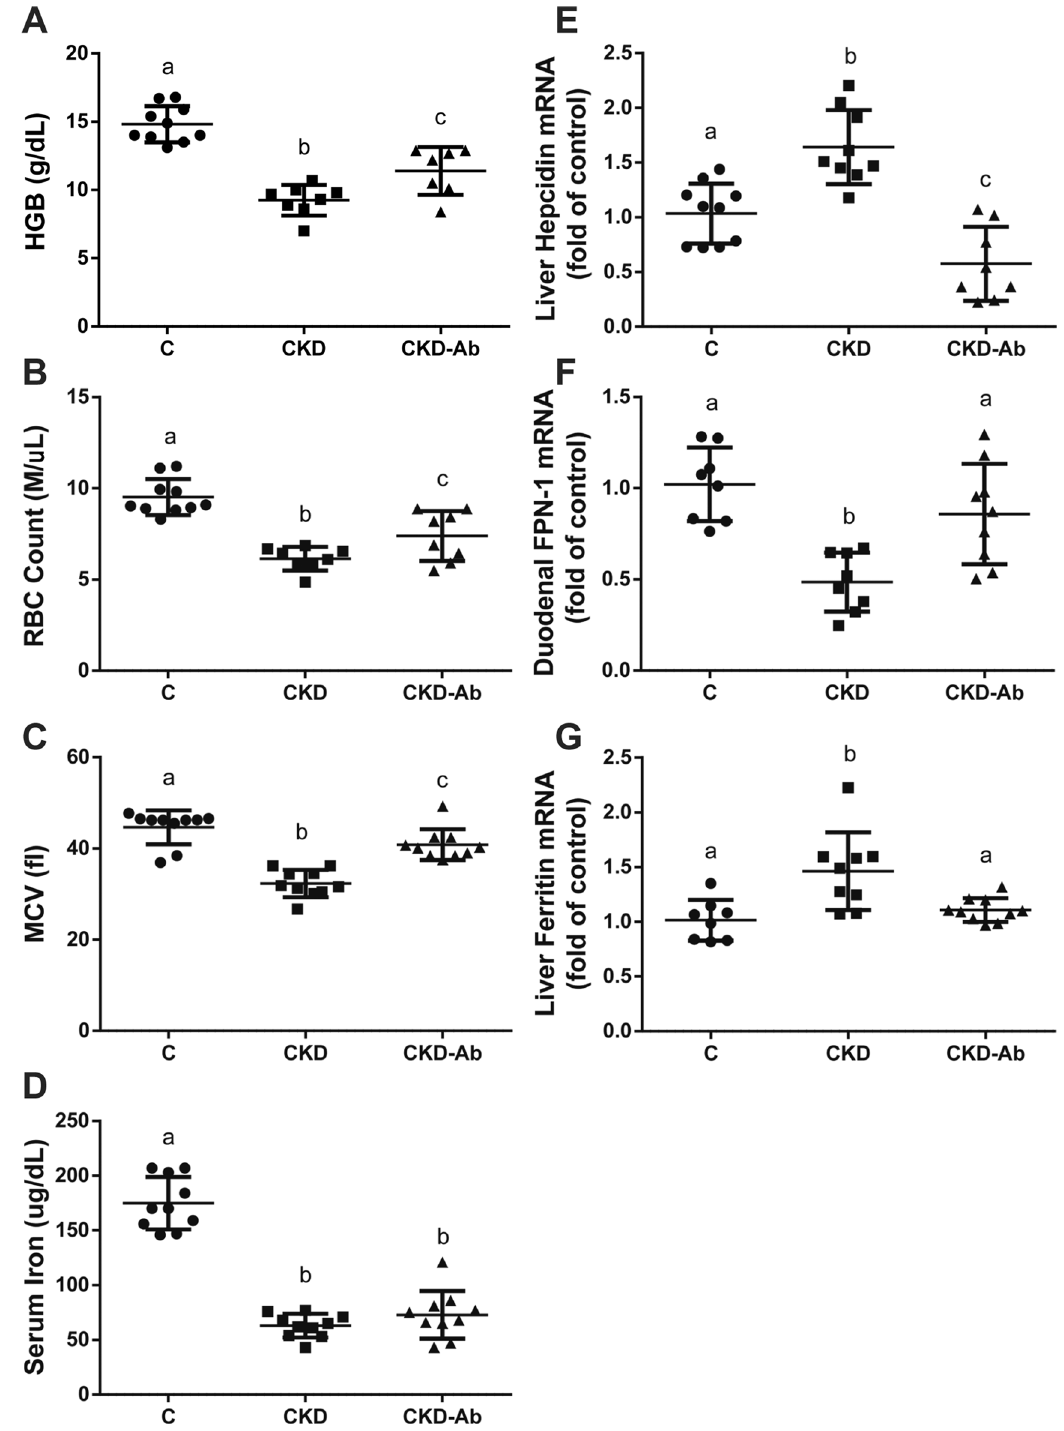
Figure 8. Anemia response of CKD mice to IL1 inhibition. Anemia and iron parameters in mice on regular (C) or adenine diet, injected with saline (CKD) or an anti-IL1 monoclonal antibody (CKD-Ab). Hemoglobin (g/dL) (A) . Red blood cell count (M/μL) (B) . Mean corpuscular volume (fl) (C) . Serum Iron levels (ug/dL) (D) . Liver hepcidin mRNA levels (E) . Duodenal ferroportin-1 mRNA levels (F) . Liver ferritin mRNA levels (G) . n = 7–10 animals per group. Different letters above bars indicate a significant difference between groups, similar letters indicate no significant